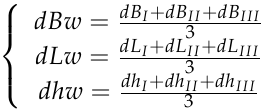
Table 3. The results of reducing the position errors according to Equations (13)–(15). Parameter Percentage Value (%)